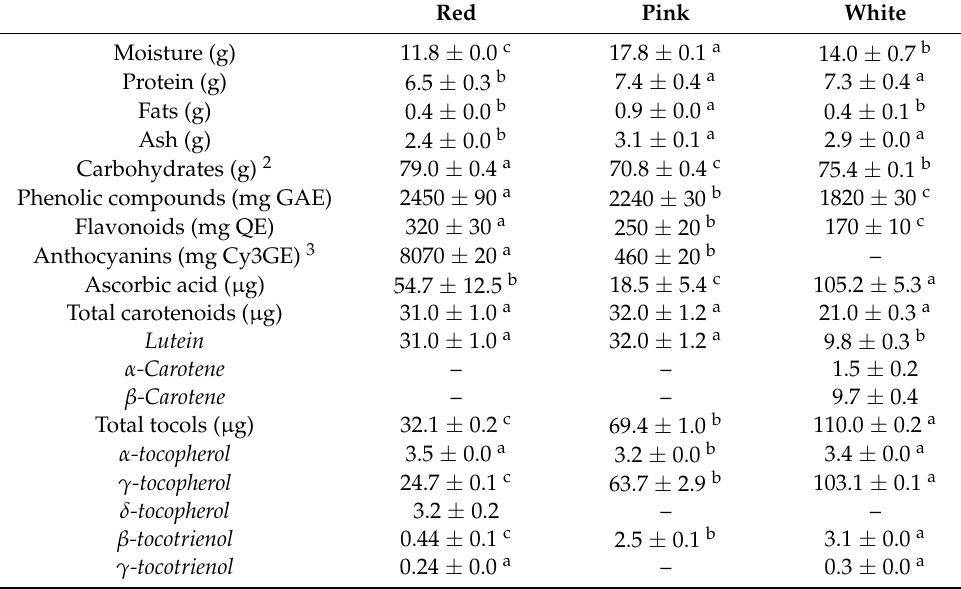
Table 1. Chemical and phytochemical composition of pomegranates of different color. 1 . Red